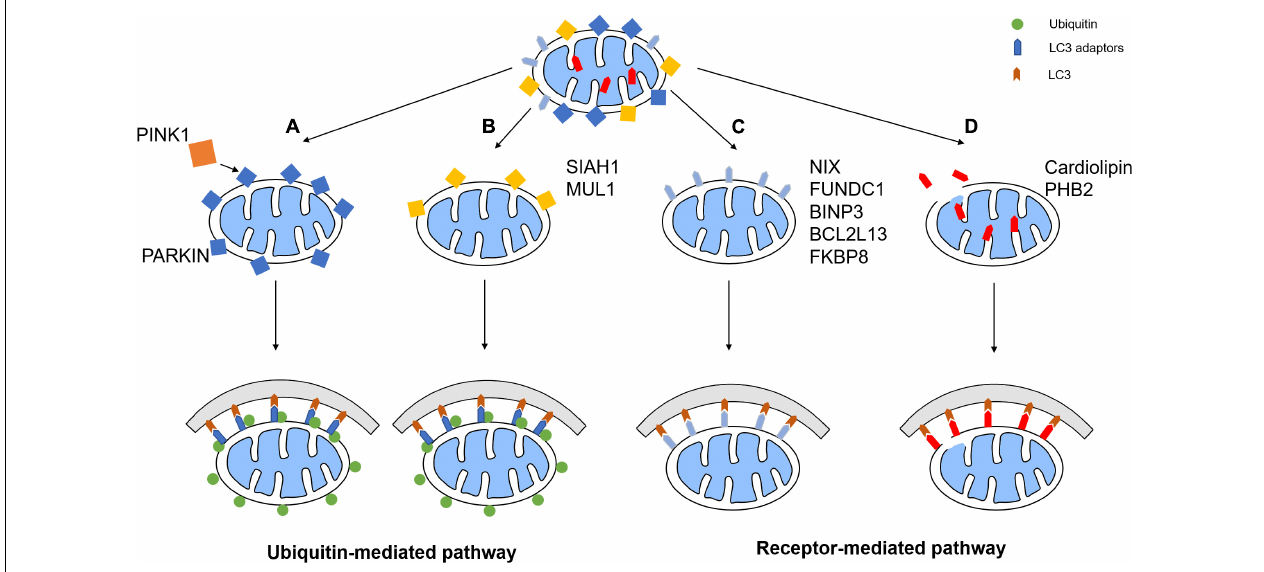
FIGURE 1 | Mitophagy pathways. The mitophagy pathways can be generally divided into two types: ubiquitin-mediated pathway and receptor-mediated pathway. (A) PINK1 phosphorylates the E3 ubiquitin ligase Parkin, which promotes the ubiquitination of OMM proteins. Some of these proteins recruit LC3 adaptors, which induces mitophagy. (B) Other E3 ligases such as SIAH1 and MUL1 also has similar pathways. (C) Some mitophagy receptors such as NIX, FUNDC1, BNIP3, BCL2L13, and FKBP8, are upregulated or activated under certain conditions, therefore recruiting phagophore to initiate mitophagy. (D) IMM receptors including cardiolipin and PHB2 recruits phagophore by interacting with LC3 to promote mitophagy.